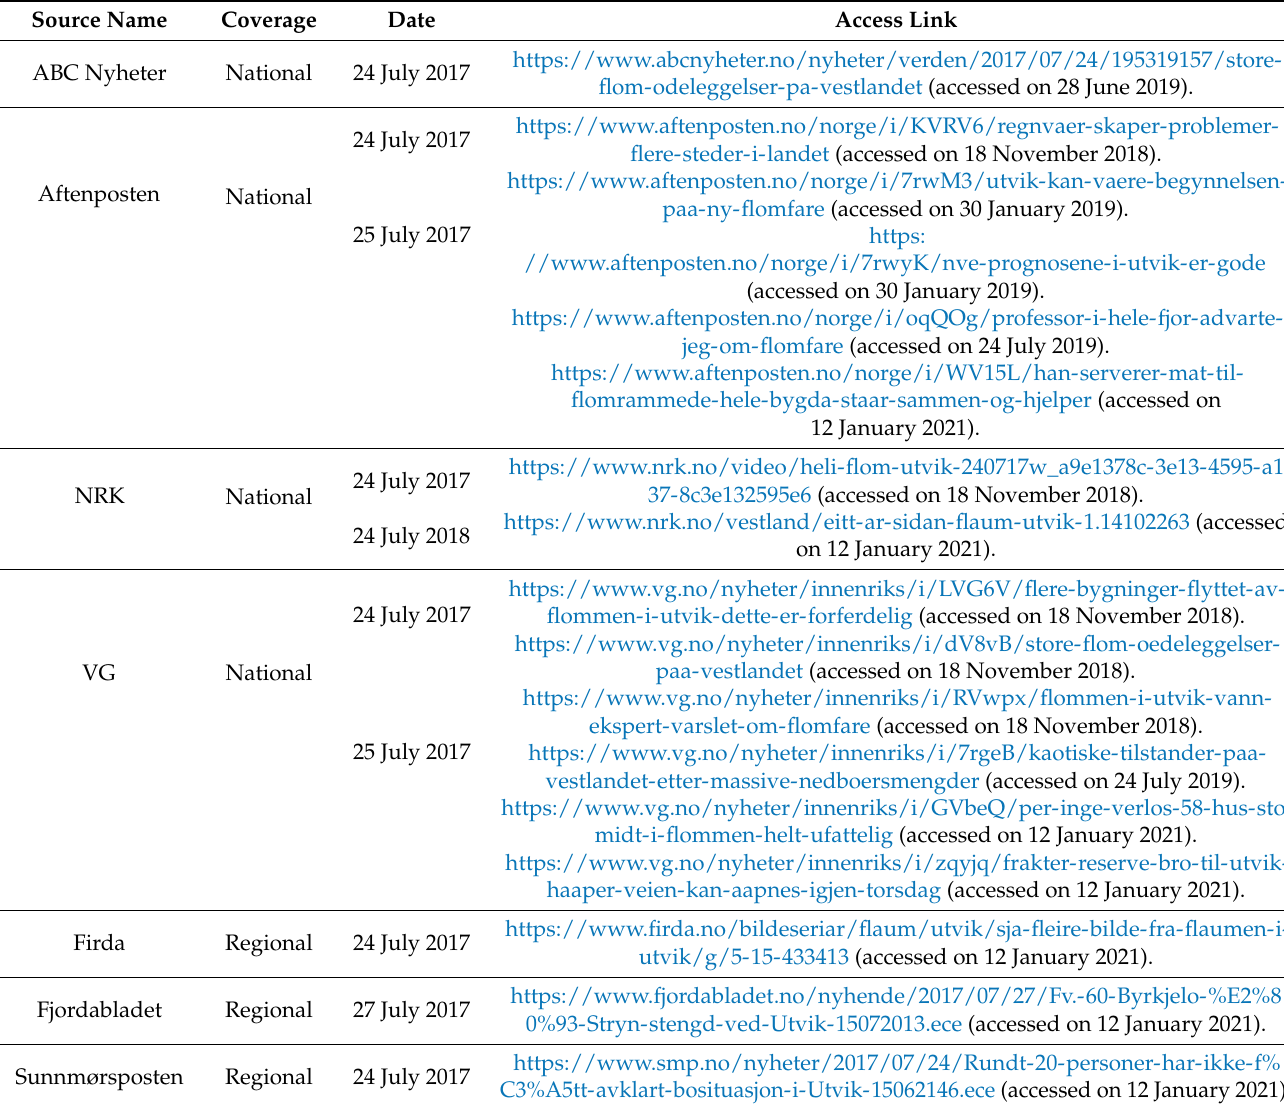
Table A1. Selected multimedia coverage of the flash flood event on 24 July 2017 in Norway. The flood was covered during, immediately after and reminisced a year